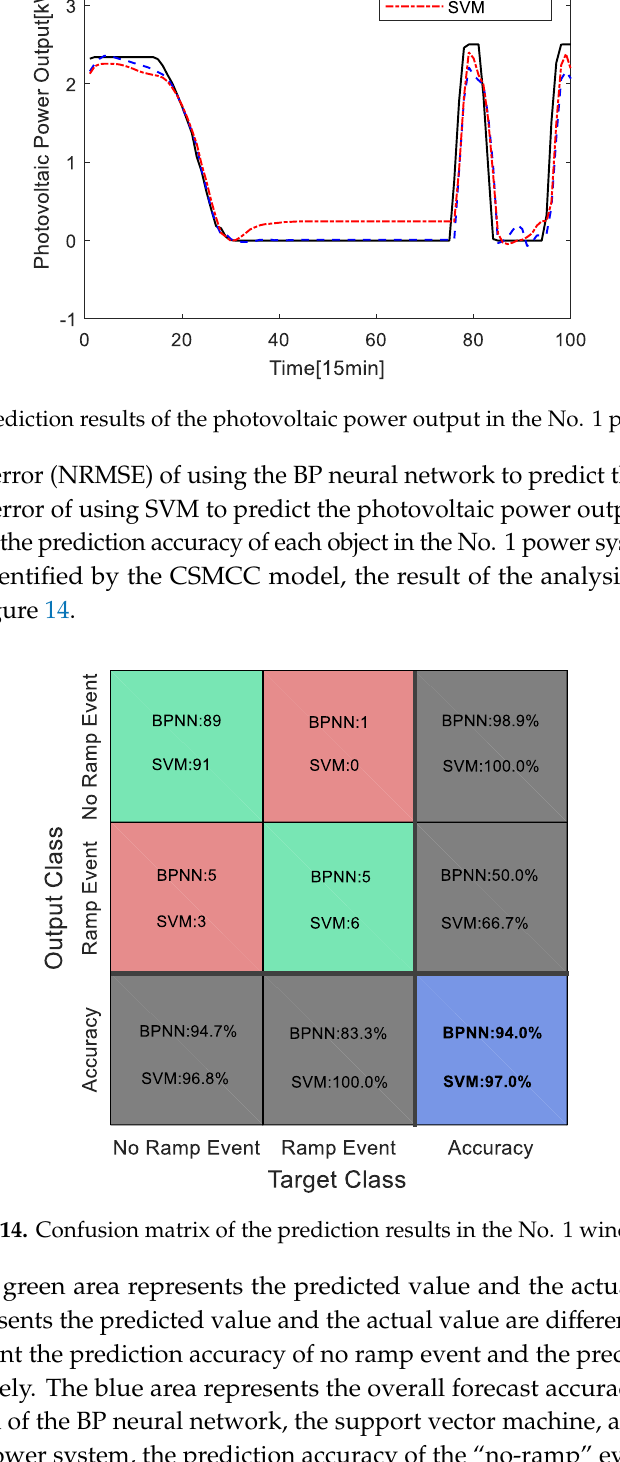
Figure 15. Prediction results of wind power output power in the No. 2 power system.